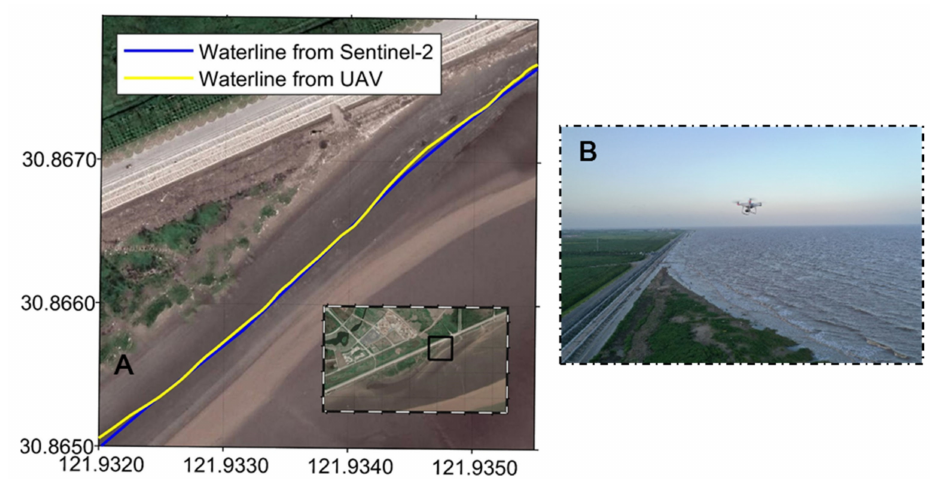
Figure 6. ( A ) The waterline positions derived from the Sentinel-2 and UAV images acquired on 31 December 2020. ( B ) The left panel shows the photo when the drone was used for the